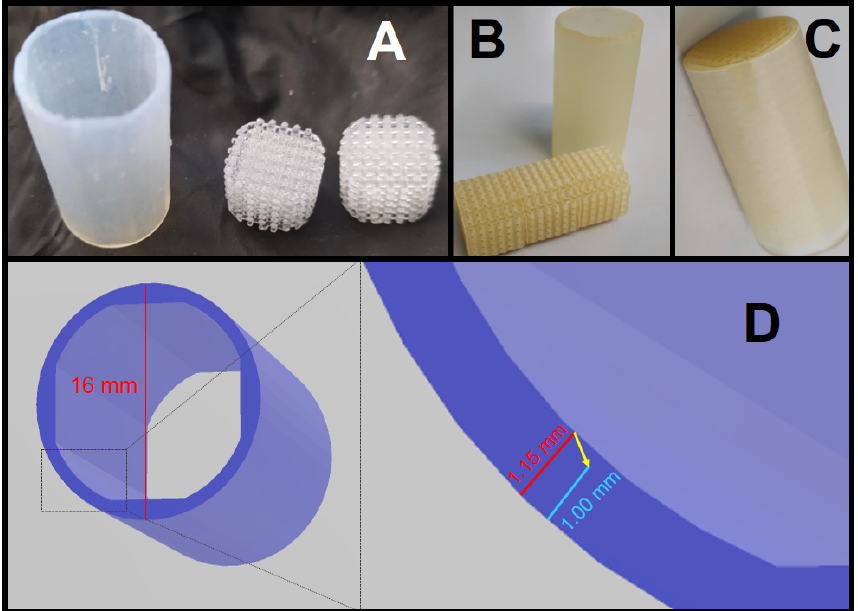
Figure 12. POCS cartridge assembly system: ( A ) parts before heat post-treatment; ( B ) pieces treated with the PT3 strategy; ( C ) assembly of 3 POCS in a single cartridge; ( D ) view of the case’s